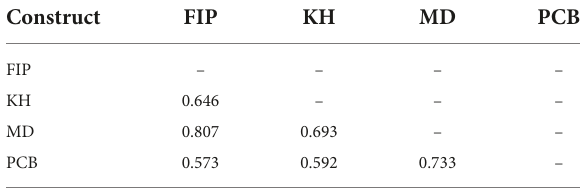
TABLE 2 Discriminant validity (Fornell-Larker-1981 criteria) (mediation). Construct